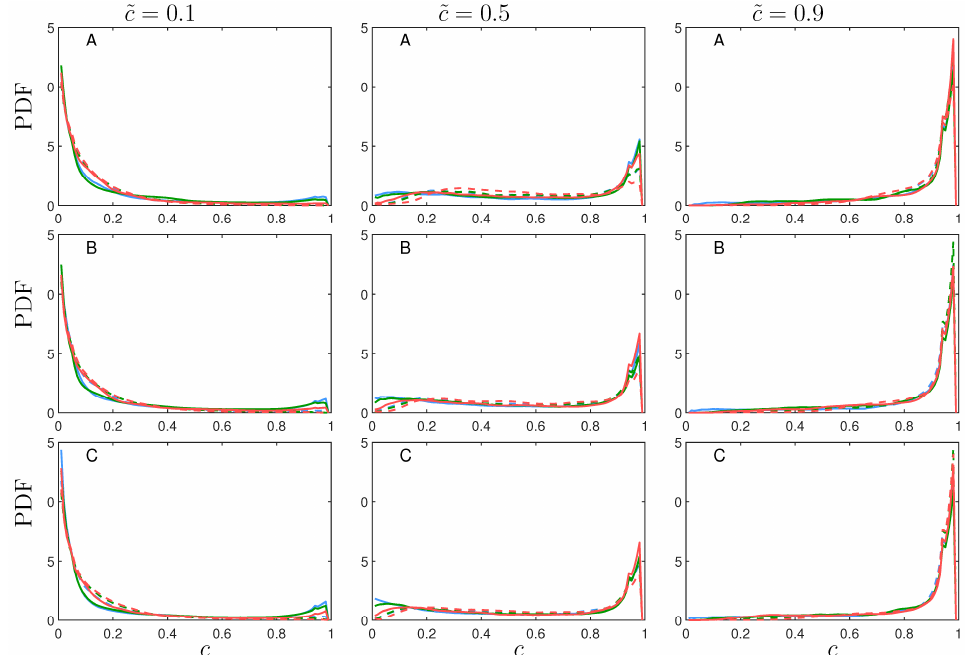
Figure 3. PDFs of 𝑐 conditional on 𝑐̃ = 0.1,0.5 ,0.9 at different locations A, B and C (top to bottom) for initial 𝑎 (cid:3031) 𝛿 (cid:3046)(cid:3047) ⁄ = 0.04 ( ), 0.05 ( ) and 0.06 ( ) with 𝑢 (cid:3040)(cid:3032)(cid:3028)(cid:3041) 𝑆 (cid:3029),(cid:3046)(cid:3047) ⁄ = 5.0 (solid line) and 10.0 (dashed line).